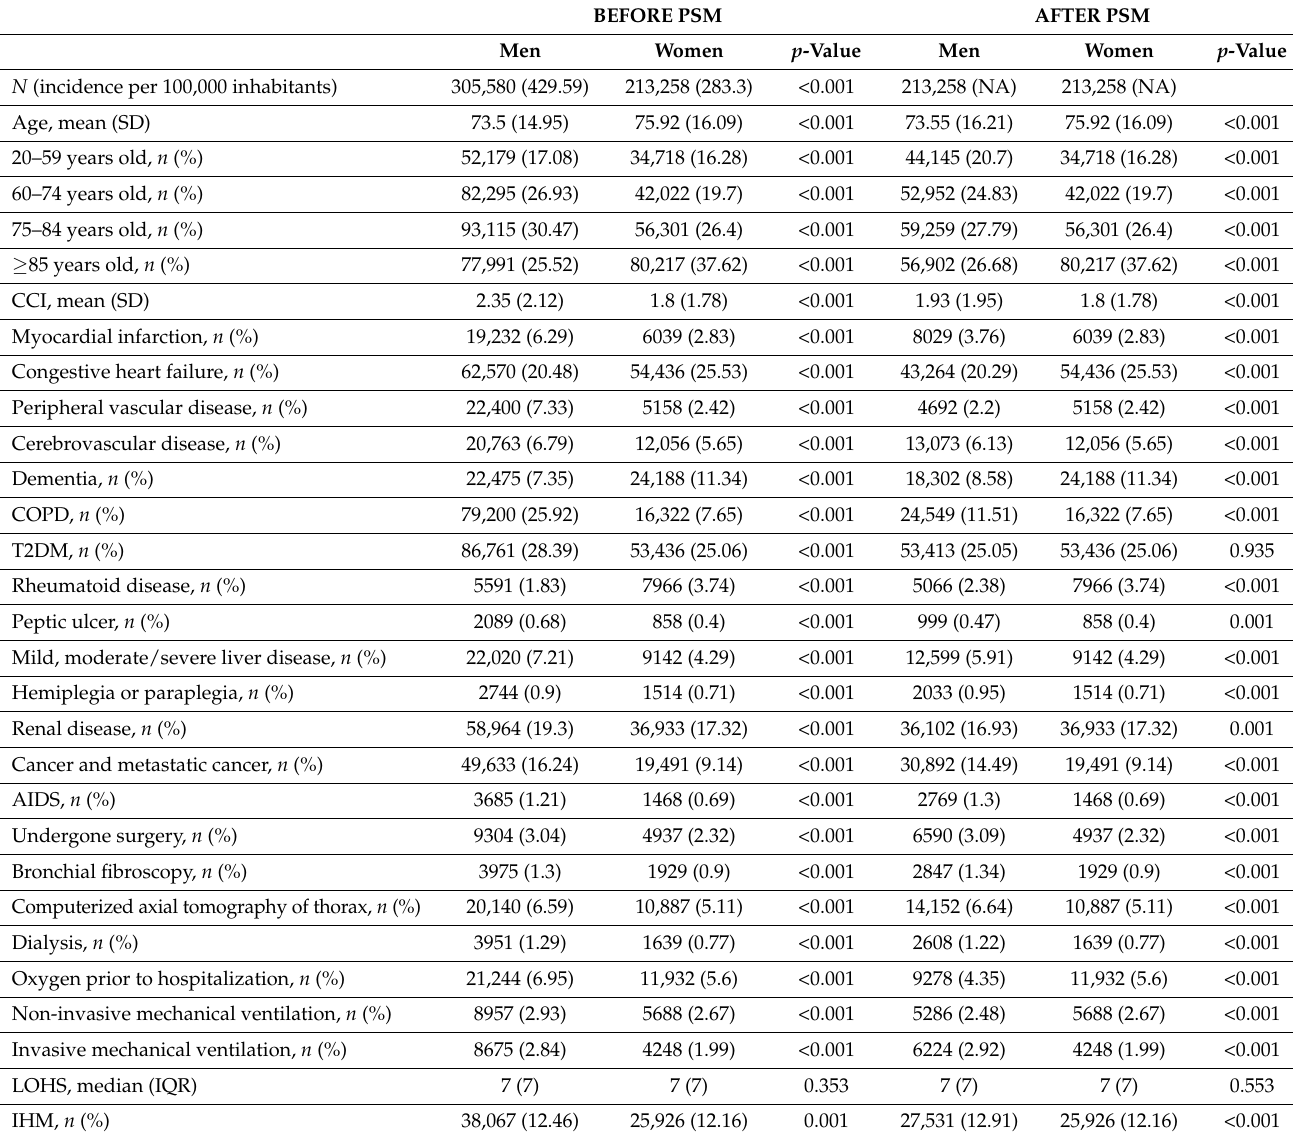
Table 3. Distribution of study covariates and hospital outcomes for women and men hospitalized with community-acquired pneumonia (CAP) in Spain (2016–2019), before and after propensity score matching